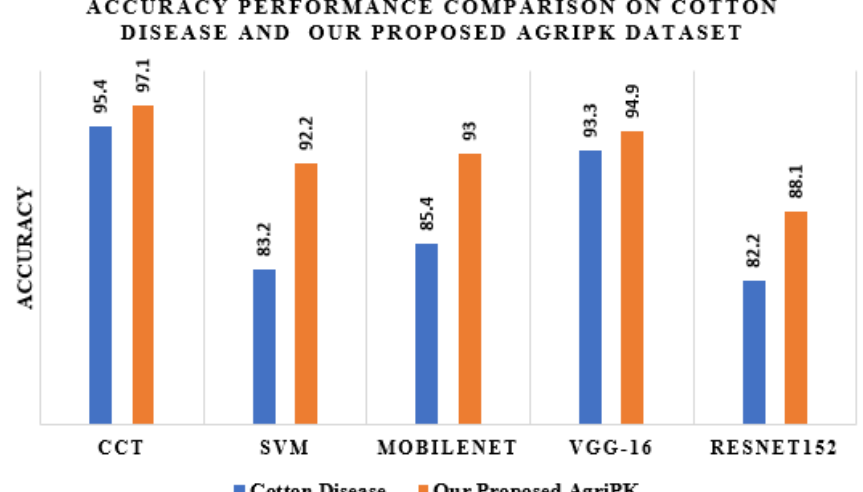
Figure 11. Performance